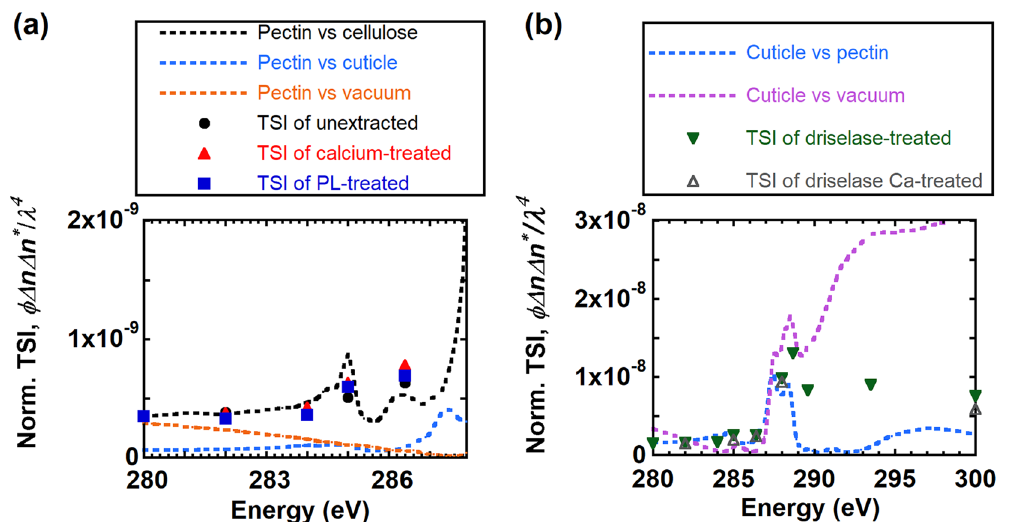
Figure 8. Comparison of TSIs (points) from ( a ) unextracted, calcium-treated, and pectate lyase-treated and ( b ) Driselase-treated and Driselase calcium-treated cell walls to the product of volume fraction and scattering contrast (dotted lines) from different cell wall components near the carbon K-edge. Volume fraction φ is proportional to the thickness of the layer where contrast